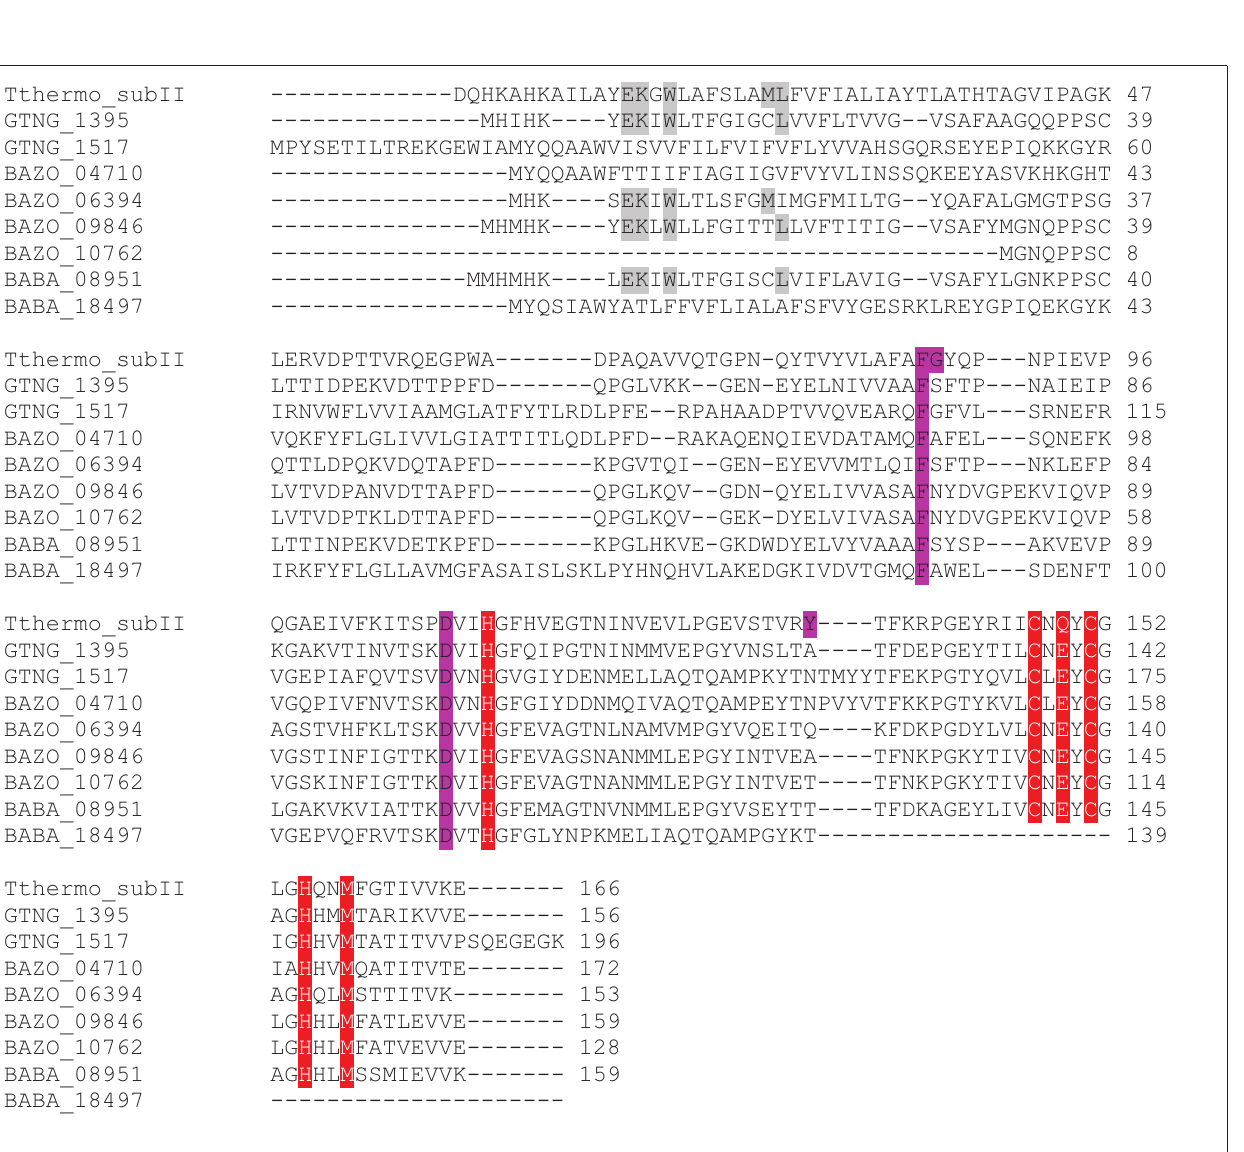
FIGURE A4 | Multiple sequence alignment of CbaB from B. azotoformans LMG 9581 T , B. bataviensis LMG 21833 T , Geobacillus thermodenitrificans NG80-2 (GTNG_1395; GTNG_1517), and